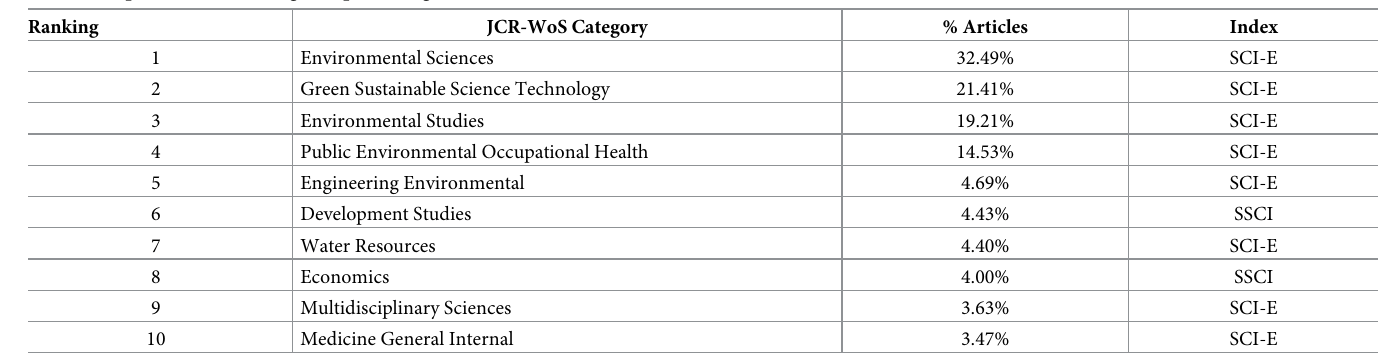
Table 1. Top ten JCR-WoS categories publishing literature on SDGs.